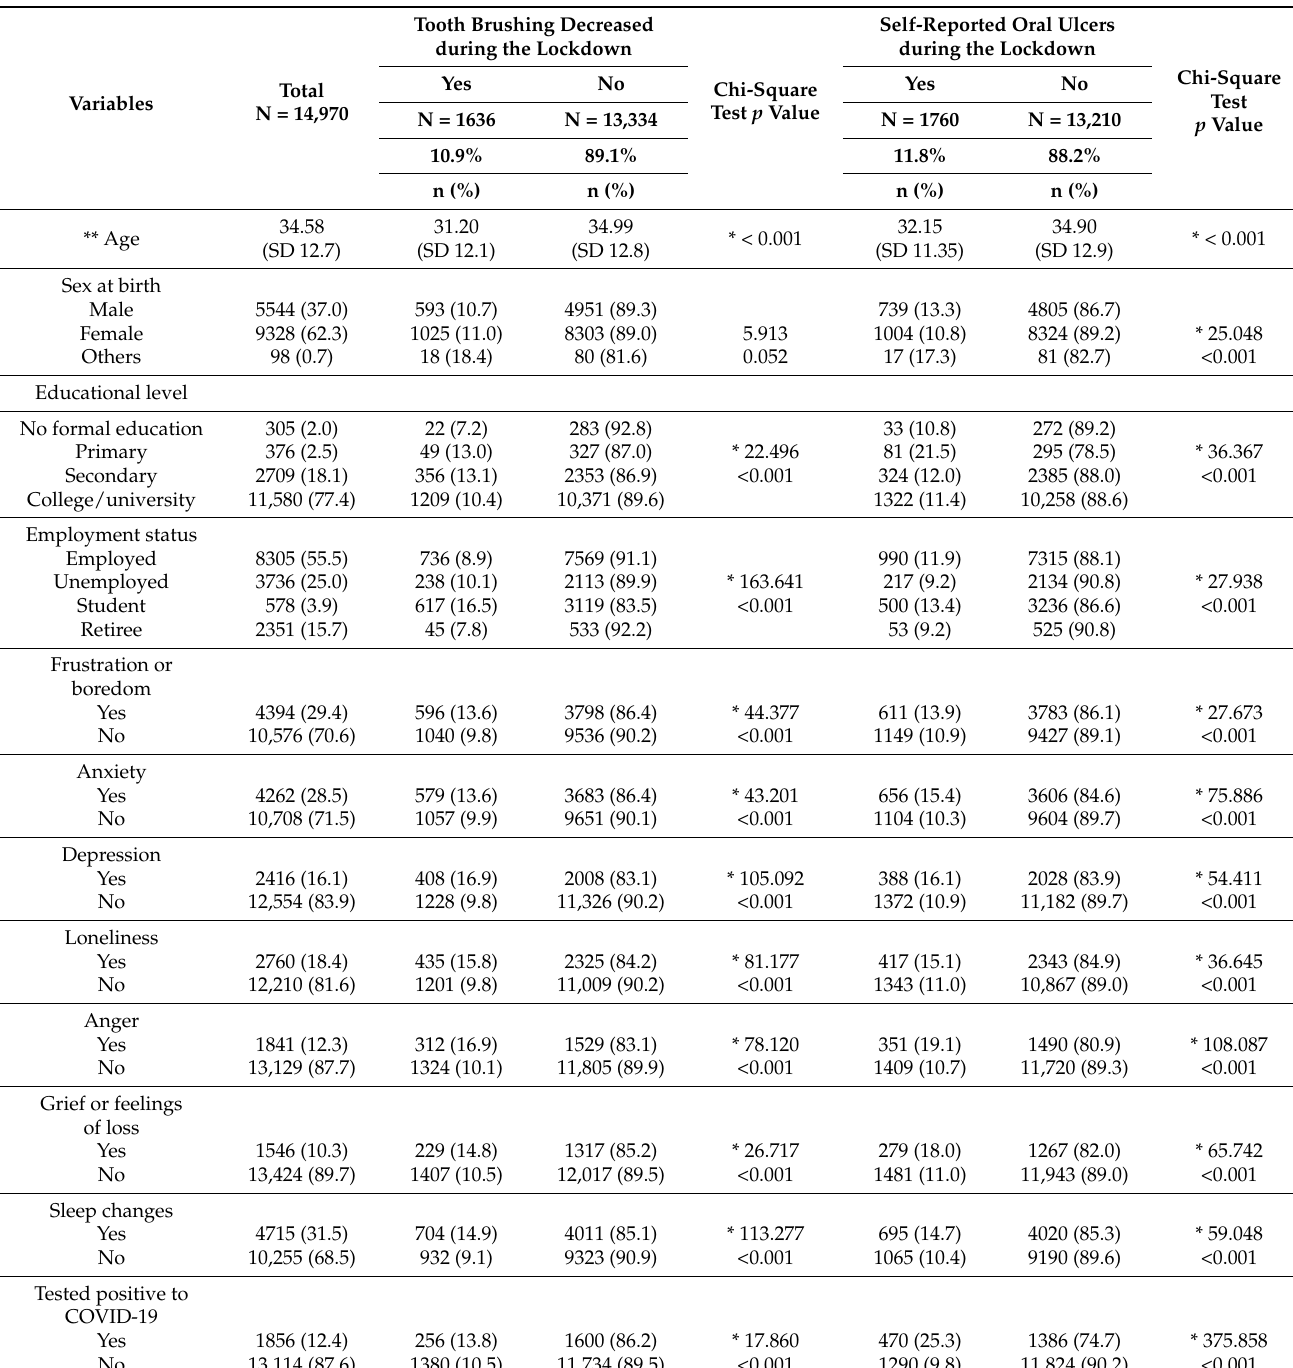
tooth brushing during the pandemic Table 1. Factors associated with decreased tooth brushing frequency and self-reported oral ulcers during the lockdown in the first wave of the COVID-19 pandemic in 152 countries (N =